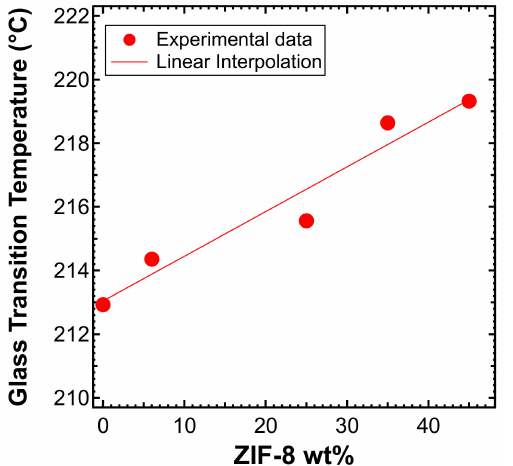
Figure 7. Trend of the glass transition temperature in ZIF-8 / PPO MMMs as a function of the filler